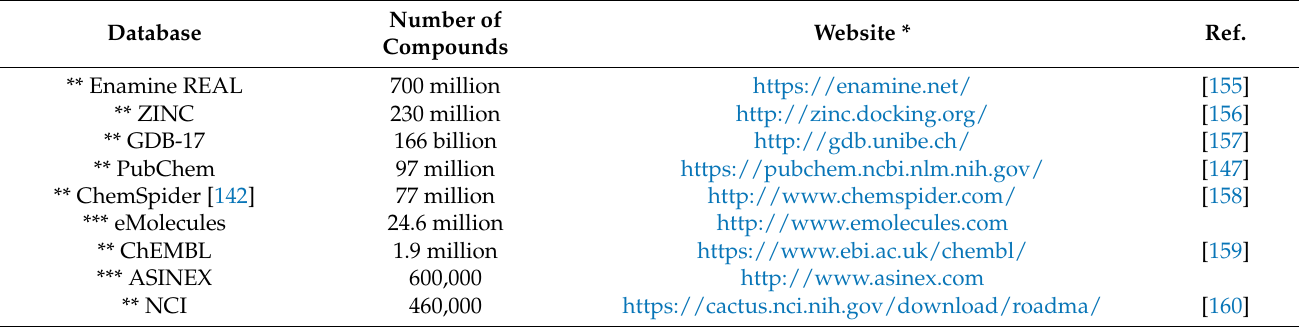
Table 6. Accessible public and commercial repositories on TB drug